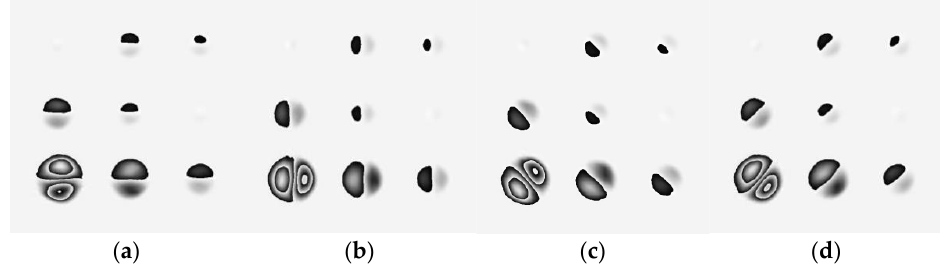
Figure 6. Shearography images in four shearing directions: ( a ) k = (0, 1) T ; ( b ) k = (1, 0) T ; ( c ) k = (0.707, − 0.707) T ; ( d ) k = (0.707, 0.707) T .